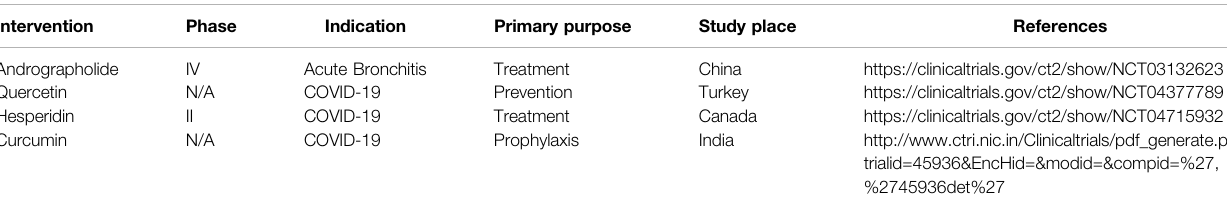
TABLE 2 | Plant metabolites studying under clinical trial as antiviral